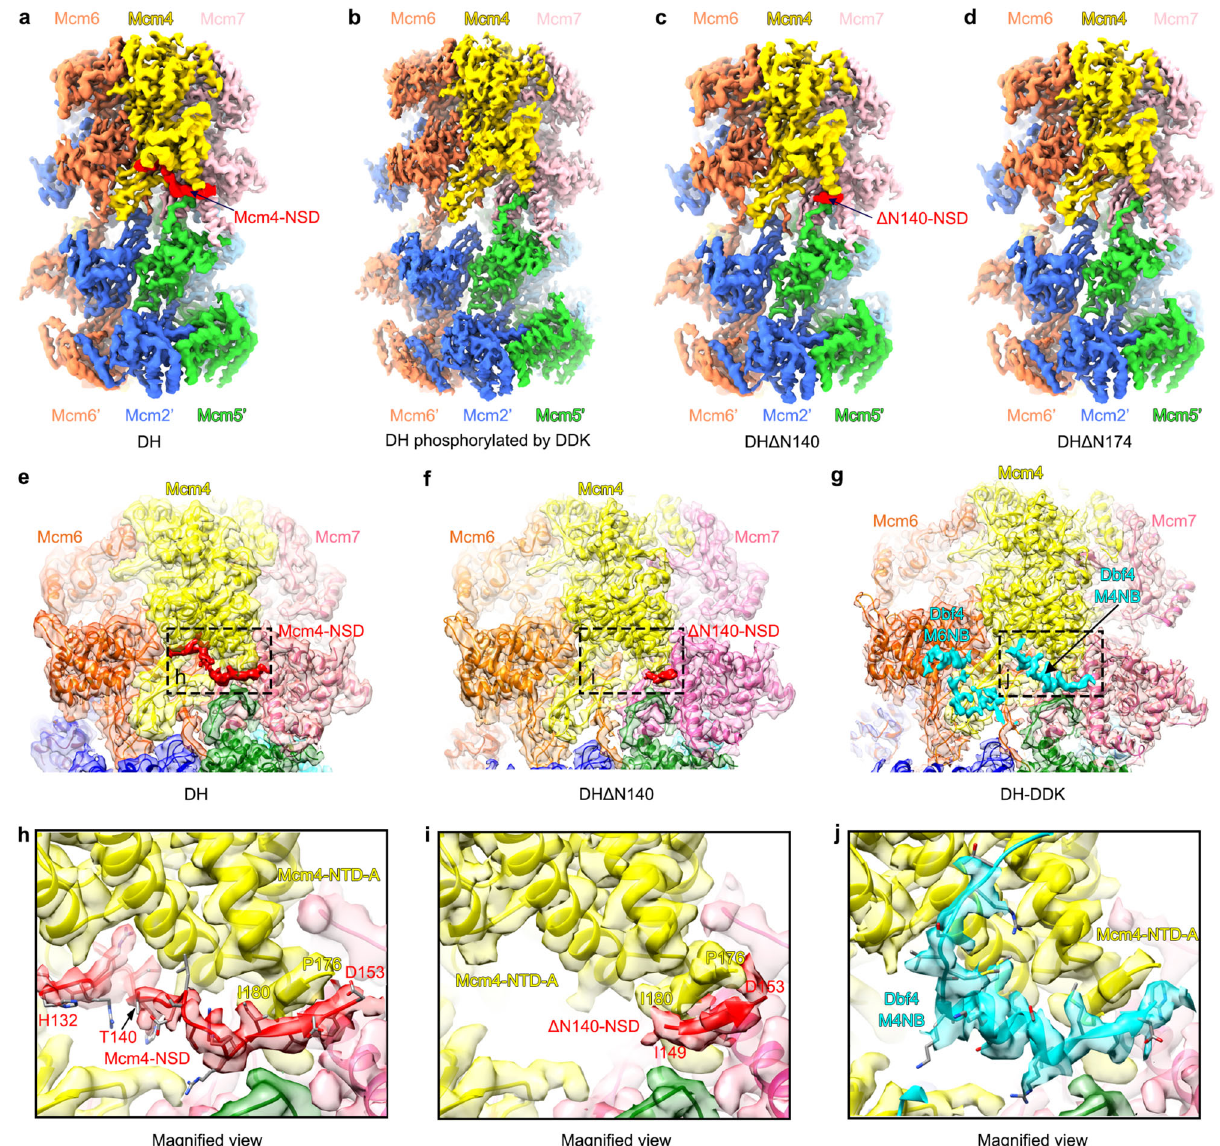
Fig. 5 Dbf4 displaces the NSD of Mcm4 on the DH. Side views of the cryo-EM density maps of the WT DH before ( a ) and after ( b ) DDK phosphorylation and the two mutant DHs, DH Δ N140 ( c ) and DH- Δ N174 ( d ). The structured fragments of Mcm4-NSD are highlighted in red. e, f Zoomed-in views of ( a ) and ( c ) with the atomic model of the DH superimposed, highlighting the structured NSD on the NTD-A of Mcm4. g Zoomed-in view of the cryo-EM map of the DH-DDK (State I) with the atomic model superimposed. The kinase core is removed to highlight the binding of the M4NB and M6NB motifs of Dbf4 to the NTD-As of Mcm4 and Mcm6. Note that the M4NB of Dbf4 and the NSD of Mcm4 share an overlapping binding surface on the NTD-A of Mcm4. h – j Magni fi ed views of the boxed regions in ( e – g )